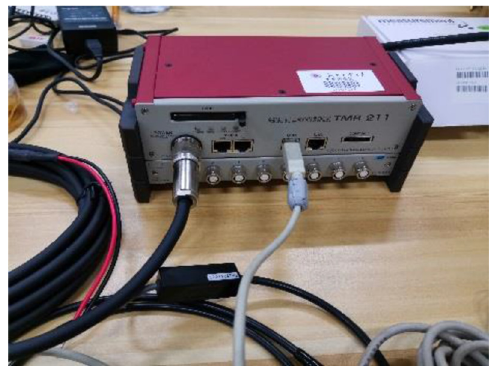
Fig. 9. Testing instrument.